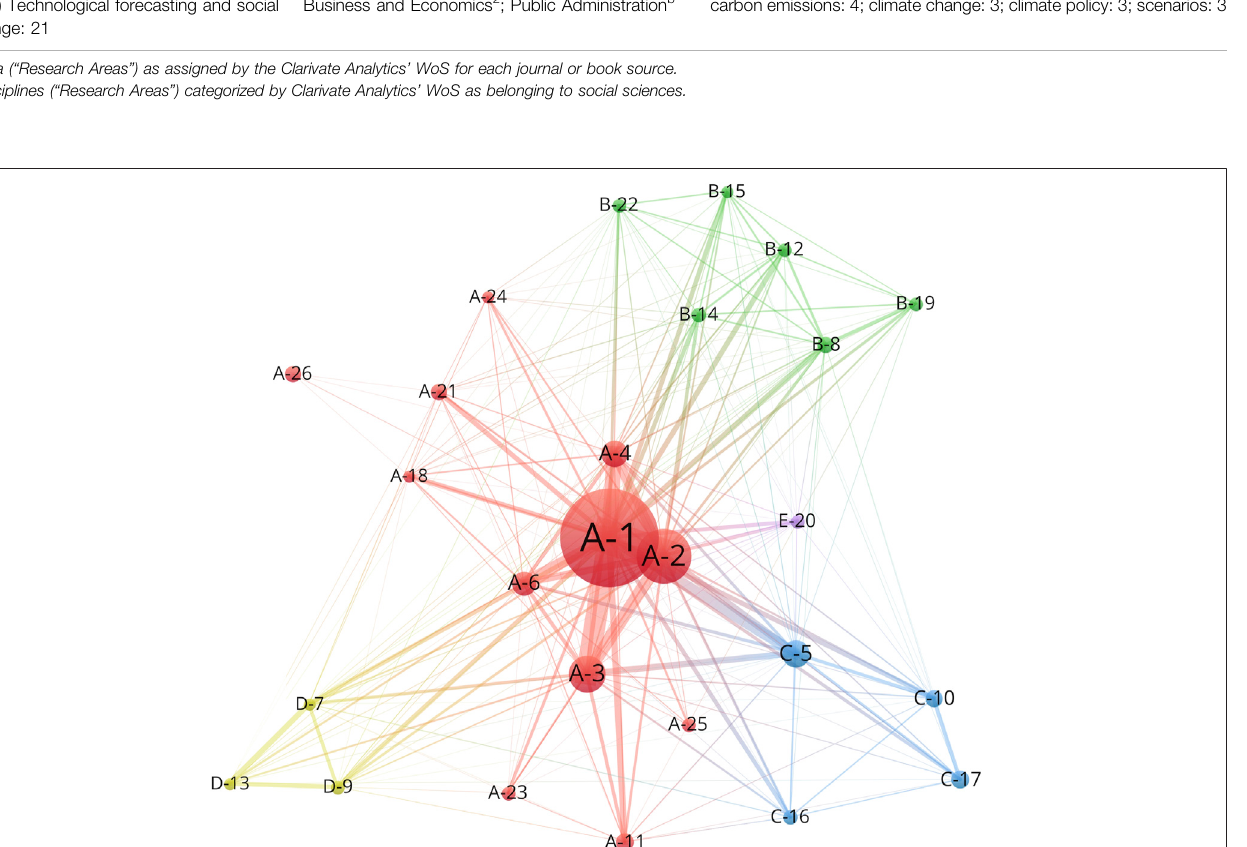
Frontiers in Environmental Science |